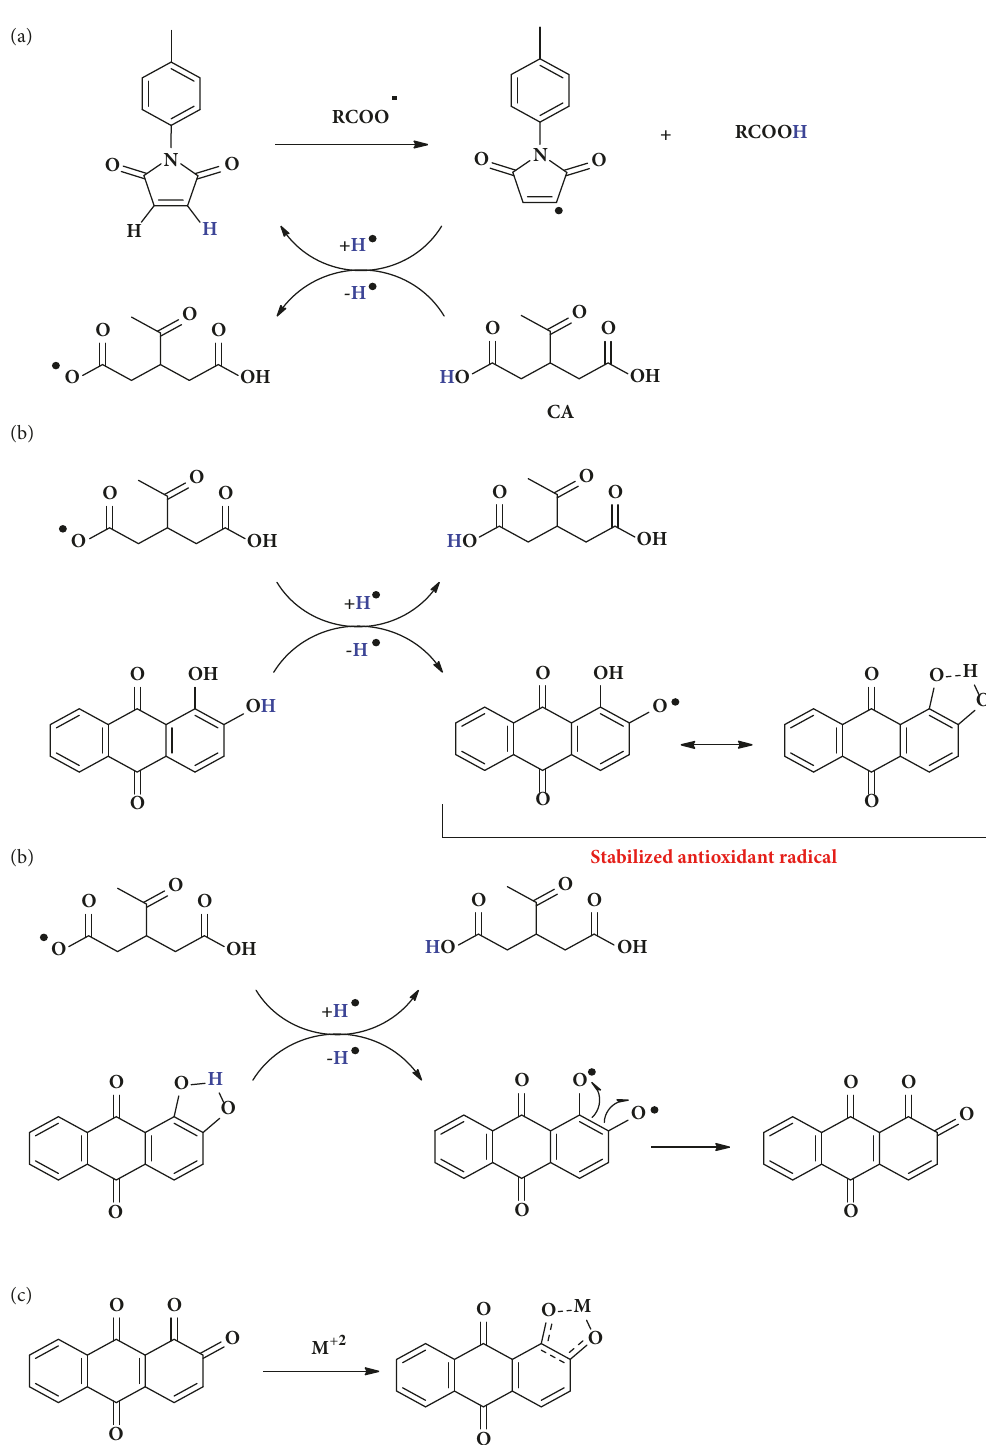
Figure 3: Proposed mechanism for the synergistic interactions between p -CH 3 , CA, and ALZ. (a) Cycle of regeneration of p -CH 3 , (b) cycle of regeneration of CA, and (c) chelation of diketone from ALZ with metals from metallic